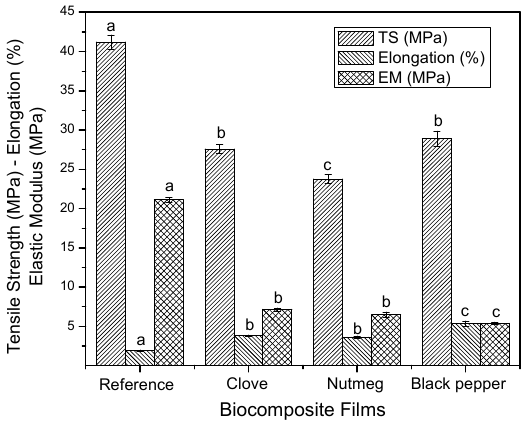
Figure 5. Mechanical properties of biocomposite films with oleoresins and reference. Different letters in the same column indicate significant differences ( p < 0.05).